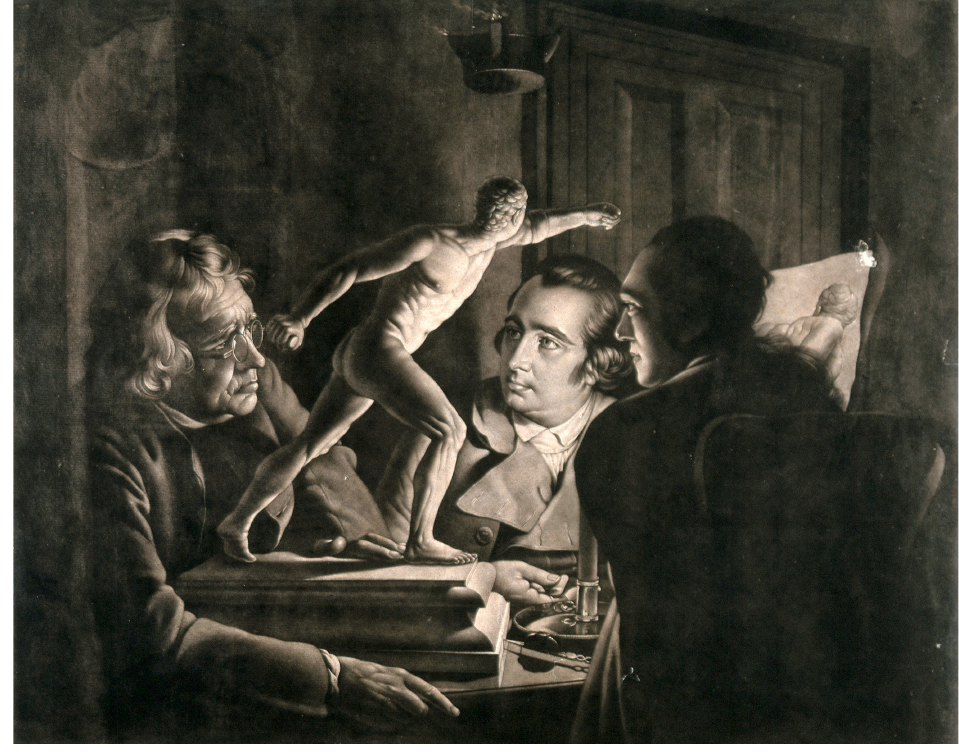
5 William Pether after Joseph Wright of Derby, Three men at a table, studying the figure of the ‘Gladiator,’ 1769. Mezzotint, 471x554mm (photo: Wikimedia Commons).